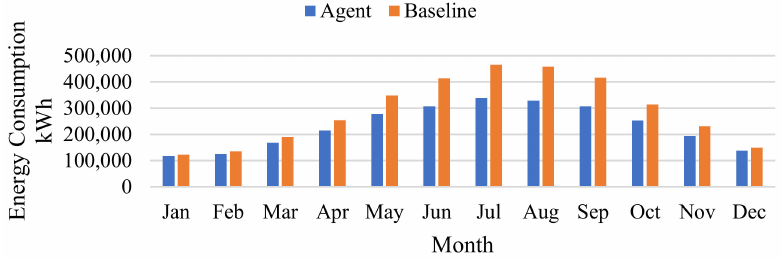
Figure 10. Energy consumption comparison between agent and